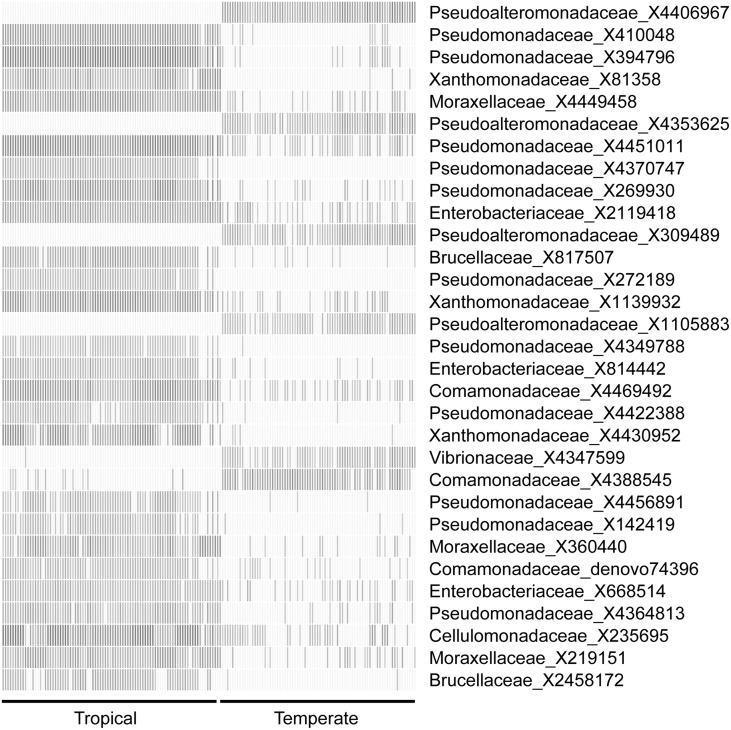
Relative abundance of 31 OTUs selected based on K-S measures that best defined the differences in skin bacterial community structure of tropical (left) and temperate (right) amphibians. Three species from each zone were included in the analysis: Agalychnis callidryas, Dendropsophus ebraccatus, Craugastor fitzingeri from Panamá (tropical zone) and Anaxyrus americanus, Lithobates catesbeianus, Pseudacris crucifer from Virginia, USA (temperate zone). OTU relative abundances ranged from 0 to 0.37. Lighter shades indicate lower relative abundances (white, relative abundance = 0) and darker shades indicate higher relative abundances (darkest relative abundance = 0.37). OTUs are ordered top to bottom based on K-S measures (see Table 3 for exact values and additional taxonomic information for each OTU).